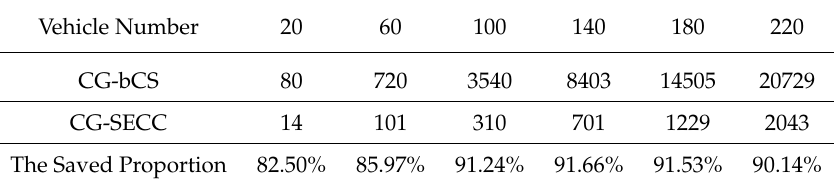
Table 1. Number of